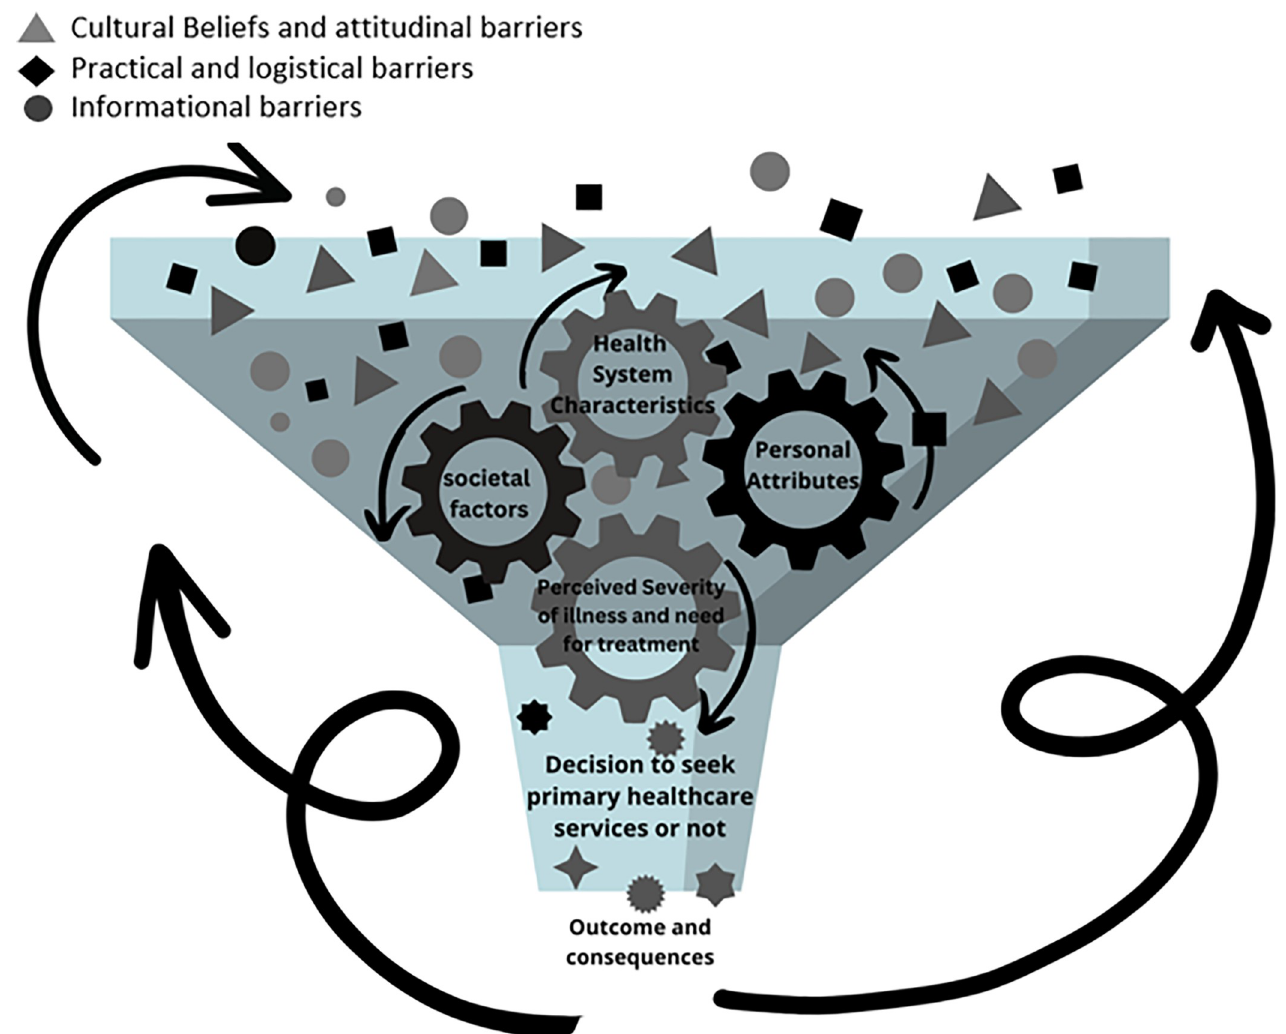
Fig 4. Conceptual model for decision making on utilizing primary healthcare services by people with